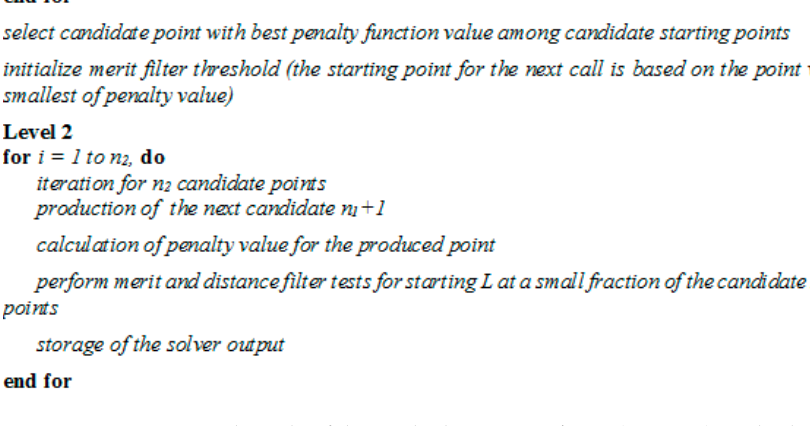
Figure 1. Pseudo-code of the applied OptQuest/NLP (OQNLP) method.